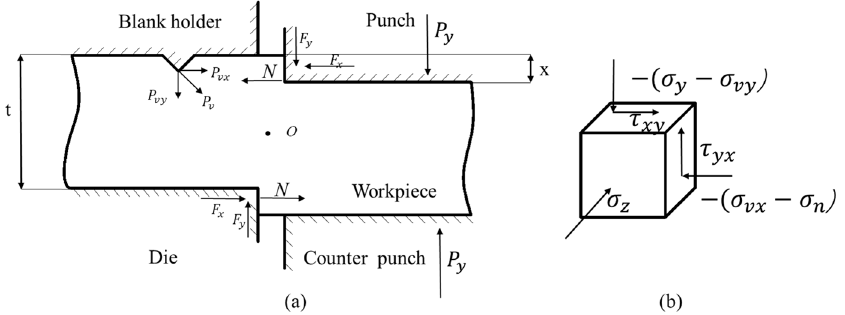
Figure 13. Schematic diagram of stress on the fine-blanking material and material in the shear deformation zone: ( a ) stress diagram of the material in the process of fine blanking; ( b ) stress distribution of the material in the deformation zone.